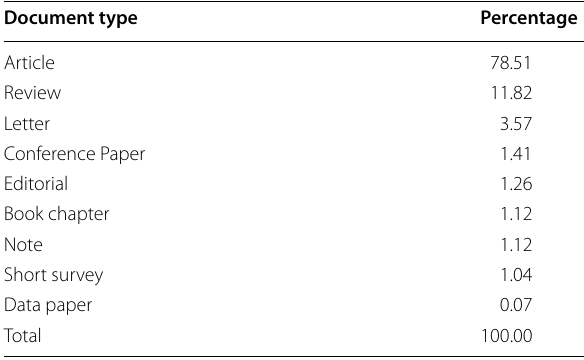
Table 1 Types of documents extracted from the